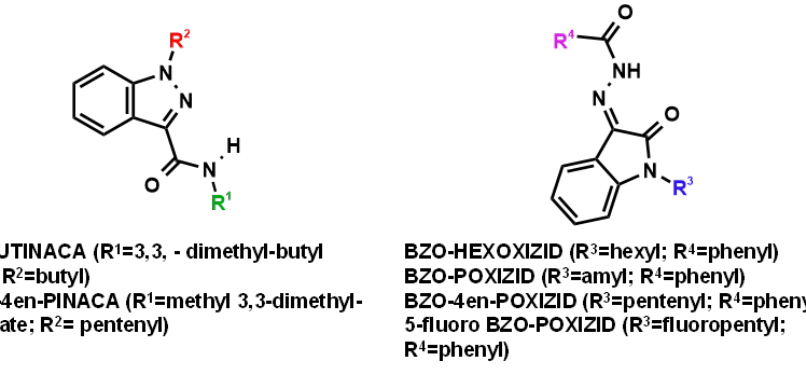
Figure 1. Molecular structures of the studied synthetic cannabinoids. Confirmation of the consumption of NPS, including SCs, requires the development of targeted methods for those compounds. Moreover, due to the limited half-life of NPS in blood and serum and their extensive metabolism, the proof of consumption often relies on the detection of metabolites in urine, a matrix characterized by a wider detection win- dow [11,12]. In fact, SCs undergo such extensive biotransformation after administration that little to no unchanged parent drug is found in human urine. Certain SC metabolites, such as monohydroxylated species, have been reported to retain some biological activity and to cross the blood–brain barrier and bind to the CB1 and CB2 receptors [13–15]. Hy- droxylated metabolites have been suggested for use as in vivo markers to identify several SCs in clinical and forensic urine samples. Therefore, metabolic studies are critical for confirming SC substance